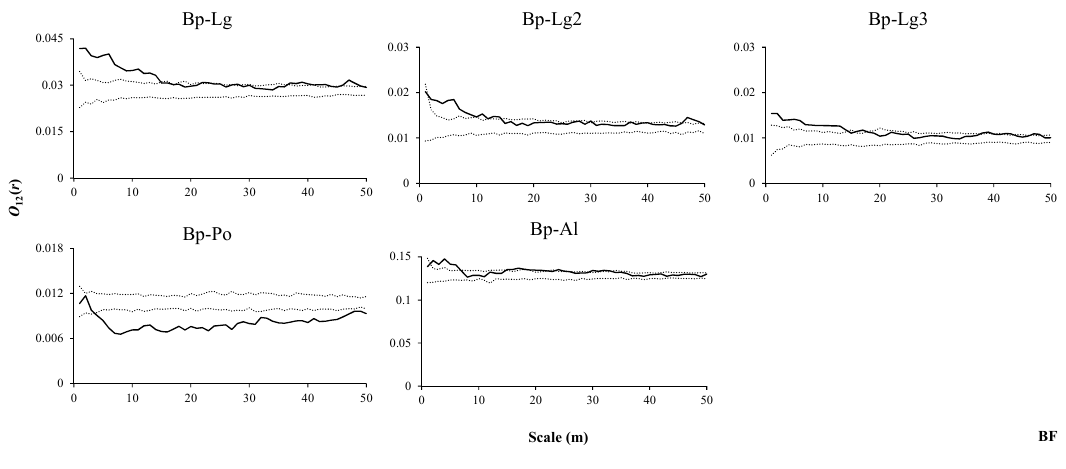
Figure 9. Spatial associations between L. gmelinii and other tree species in CBMF. In the CMF, L. gmelinii (the dominant species) and P. koraiensis were negatively associated at small scales, not associated at intermediate scales, and positively associated at large scales (Figure 10, Lg–Pi). L. gmelinii was mainly not associated, and negatively associated with seedlings and small trees of P. koraiensis at scales from 1 to 20 m, respectively, while these groups presented positive associations and no associations at other scales, respectively. L. gmelinii and saplings of P. koraiensis mainly presented no associations (Figure 10, Lg–Pi1, Lg–Pi2, Lg–Pi3). With increasing size, negative associations, no associations, and positive associations were found, in order, between L. gmelinii and medium-sized trees and adult trees of P. koraiensis (Figure 10, Lg–Pi4, Lg–Pi5). L. gmelinii mainly showed positive associations with seedlings and the whole trees of P. sylvestris var. mongolica at all scales (Figure 10, Lg–Ps, Lg–Ps1), L. gmelinii were mainly positively associated with saplings and adult trees of P. sylvestris var. mongolica at scales from 1 to 20 m (Figure 10, Lg–Ps2, Lg–Ps5), respectively, and were mainly positively associated with small trees and medium-sized of P. sylvestris var. mongolica at 135- m scales, respectively (Figure 10, Lg–P3, Lg–Ps4). L. gmelinii mainly showed no associations with saplings, small trees, medium-sized trees, and all individuals of B. platyphylla